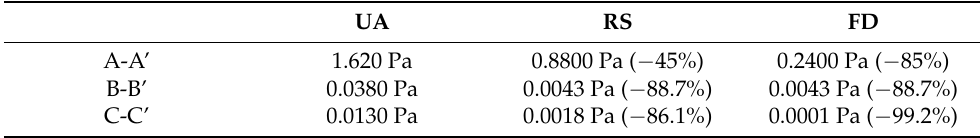
Table 1. WSS for the systolic cardiac flow. Table 2. WSS for the diastolic cardiac